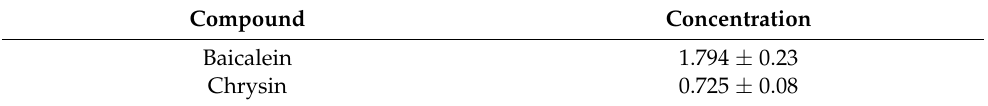
Table 2. The concentration of baicalein (Bcl) and chrysin (Chr) expressed as mg/g dry wt. of powder in O. indicum Vent.